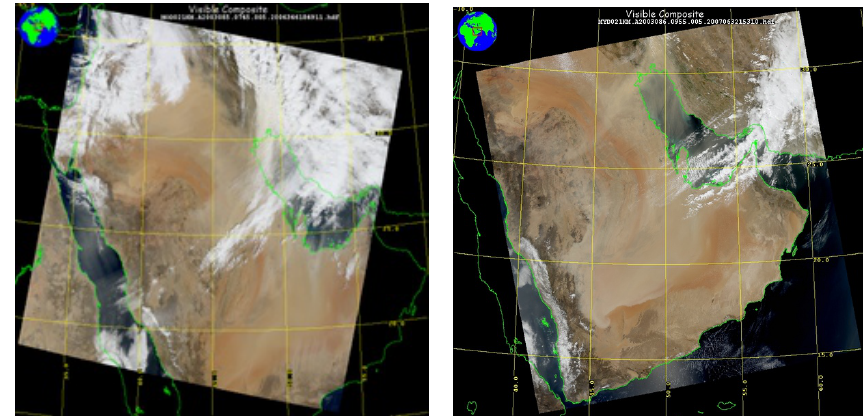
Fig. 8. Terra-MODIS RGB image captured on 26 March shows the dust front moving from the northwesterly direction into Kuwait (a) . The 27 March rising dust captured by Aqua MODIS shows clearly a thin layer of dust covering most of the Arabian (Persian) Gulf (b) .